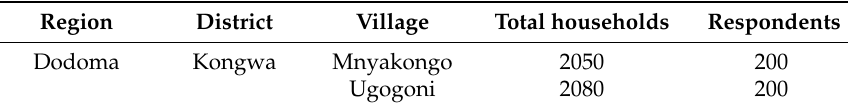
Source: Field Survey Data,